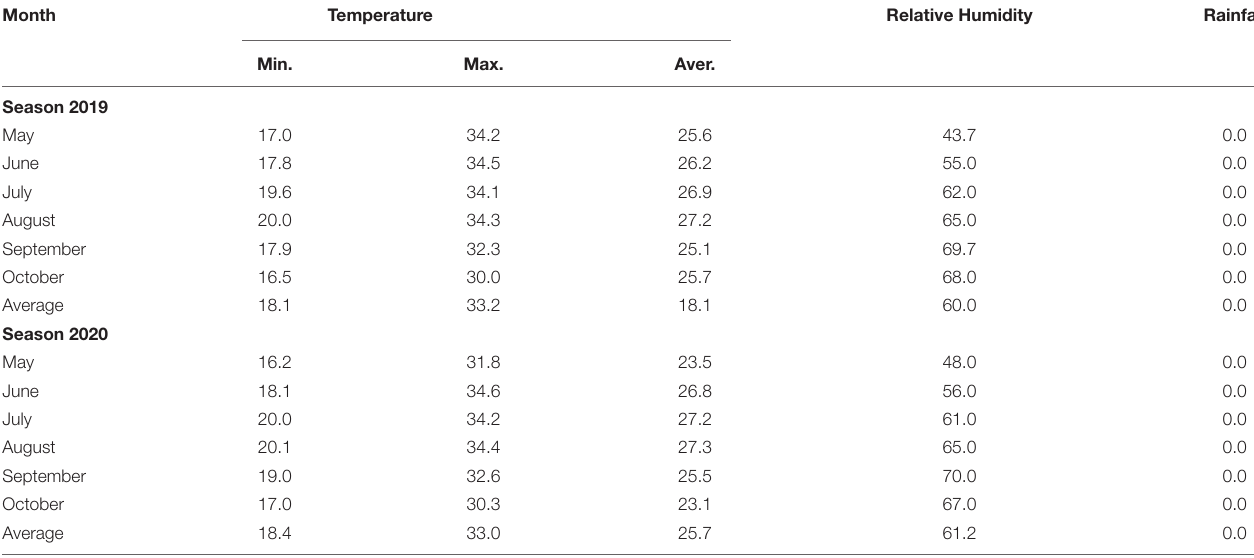
TABLE 2 | Mean temperature (C ◦ ), relative humidity (%) and rainfall (mm) at Giza, Egypt during 2019 and 2020 seasons. Month Temperature Relative Humidity Rainfall Min.